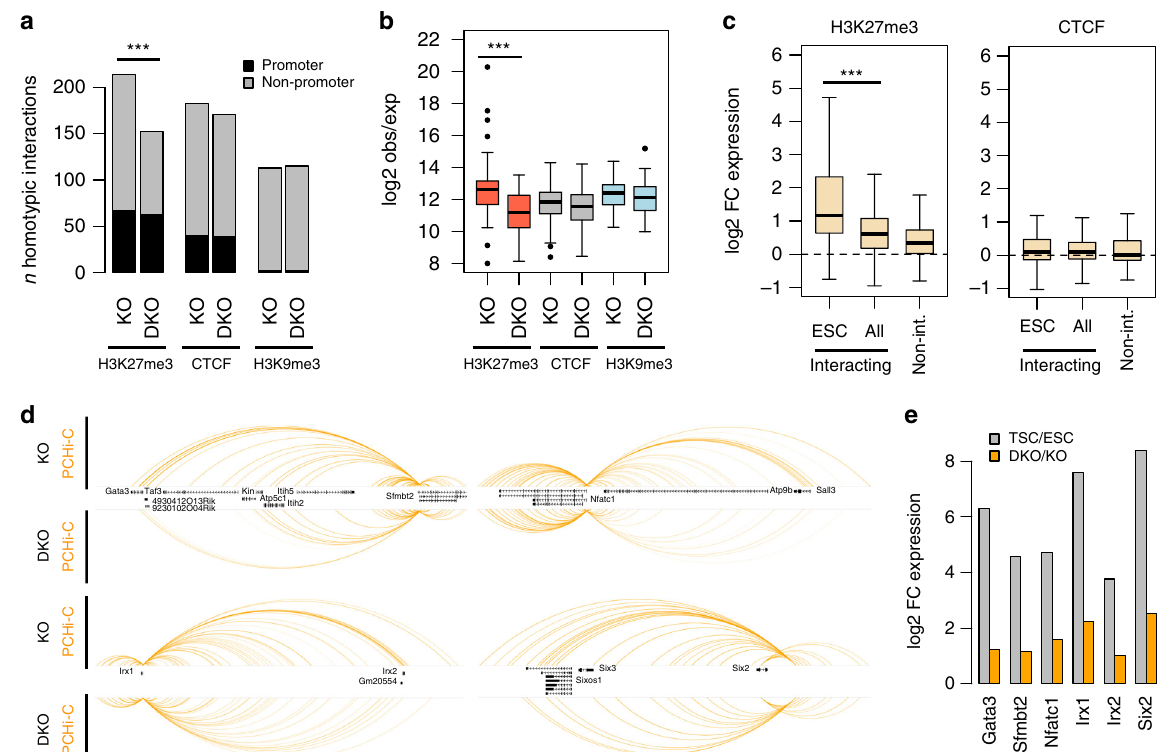
Fig. 3 ESC-speci fi c H3K27me3 homotypic interactions require PRC1. a Number of wild-type homotypic interactions (involving the indicated proteins/ modi fi cations) found in Ring1A KO or Ring1A/B DKO ESCs. b Strength of the preserved homotypic interactions (measured as log2 observed/expected PCHi-C signal) in Ring1A KO or Ring1A/B DKO ESCs. *** p < 0.0005 ( t -test, corrected for multiple KO-DKO comparisons). c Expression ratio (log2) between Ring1A/B DKO and Ring1A KO ESCs for genes involved in either H3K27me3 or CTCF homotypic interactions (all or ESC-speci fi c), and compared with genes not involved in homotypic interactions. *** p < 0.0005 ( t -test). d Interaction pro fi les in Ring1A KO or Ring1A/B DKO ESCs for the regions highlighted in Fig. 2e, f. e Expression ratio between Ring1A/B DKO and Ring1A KO ESCs for TSC-expressed genes involved in the interactions highlighted in d . Boxplot midline represents median, box edges the fi rst and third quartiles, and whisker edges are the last data points within 1.5× the interquartile